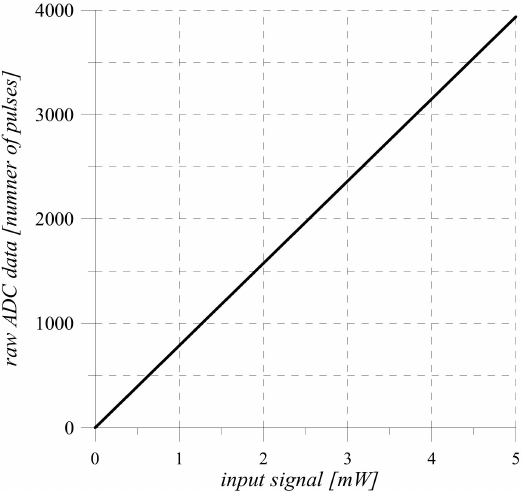
Figure 3. Voltage changing at the output of the shunt.